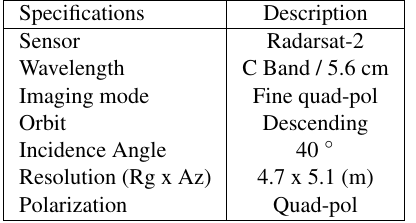
Table 1. Image characteristics (Morena et al.,